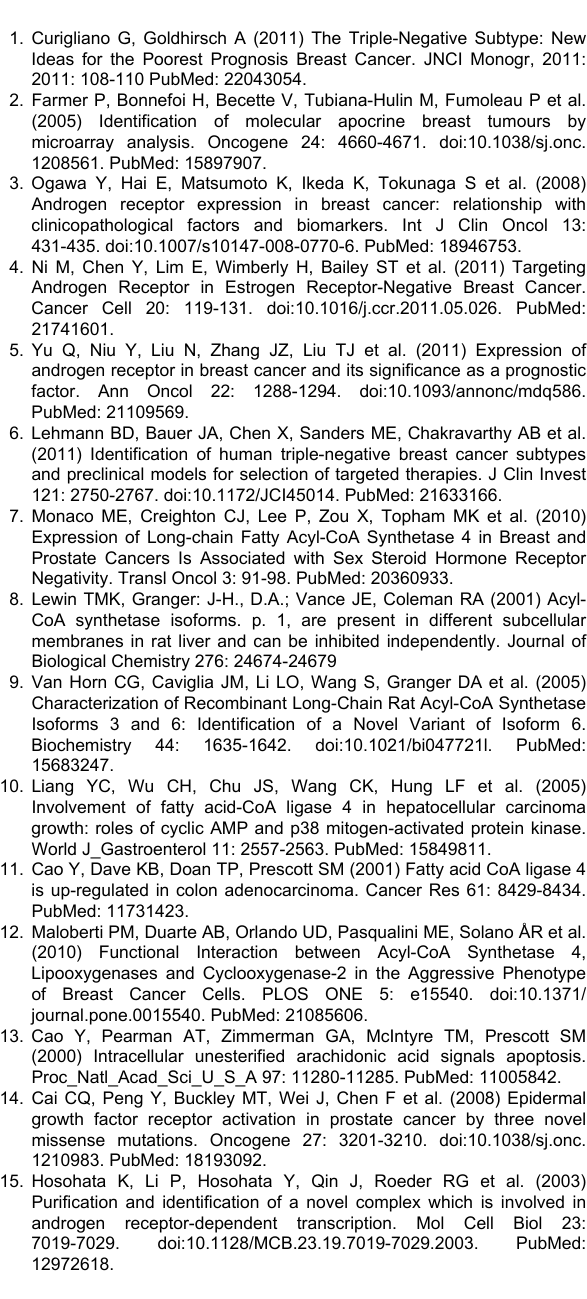
Table S2. Common affected pathways. An analysis of the results detailed in table S1 using methods described in the text.